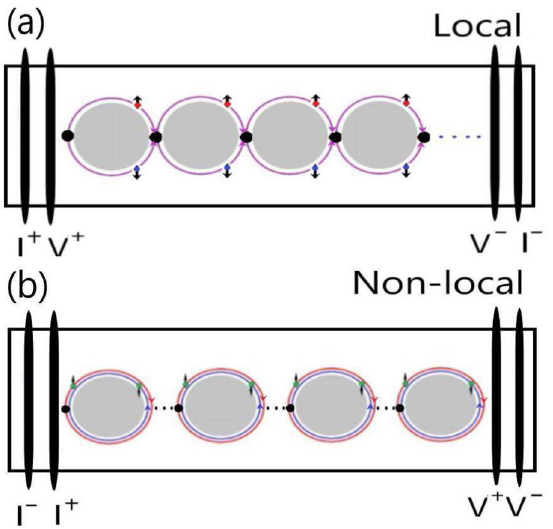
Figure 4. The cartoons of AB-like and AAS-like interferences. ( a ) The AB-like interference is dominant in the local configuration. ( b ) the AAS-like interference is dominant in the nonlocal